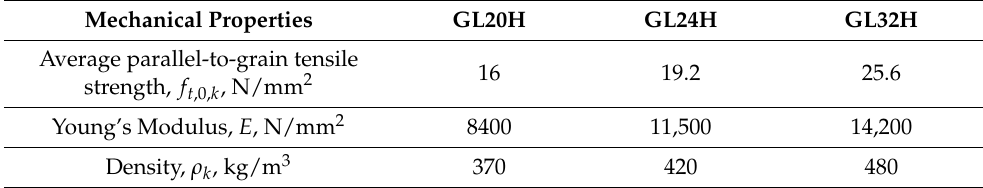
Table 1. Mechanical properties for glulam at approximately 12% moisture content [9,20,21]. Mechanical